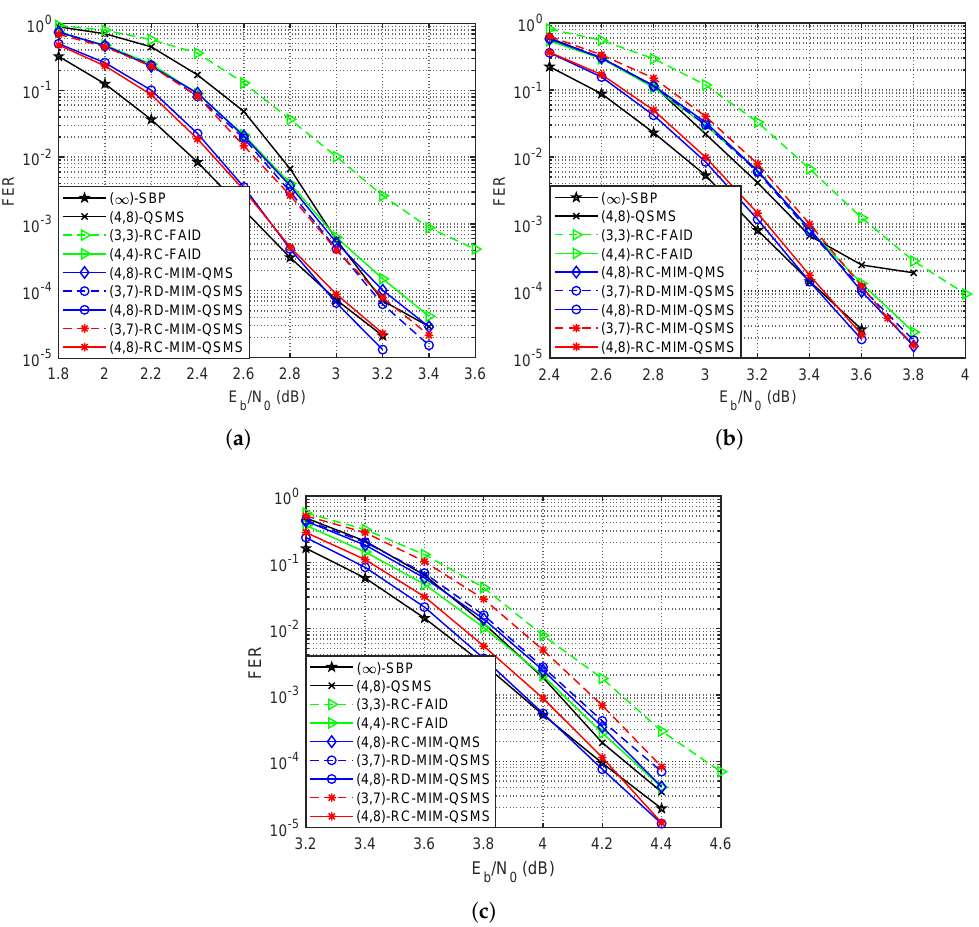
Figure 2. The FER performance of different decoders for the length-1296 IEEE 802.11n LDPC codes with code rates 2/3, 3/4, and 5/6. ( a ) R c = 2/3. ( b ) R c = 3/4. ( c ) R c =